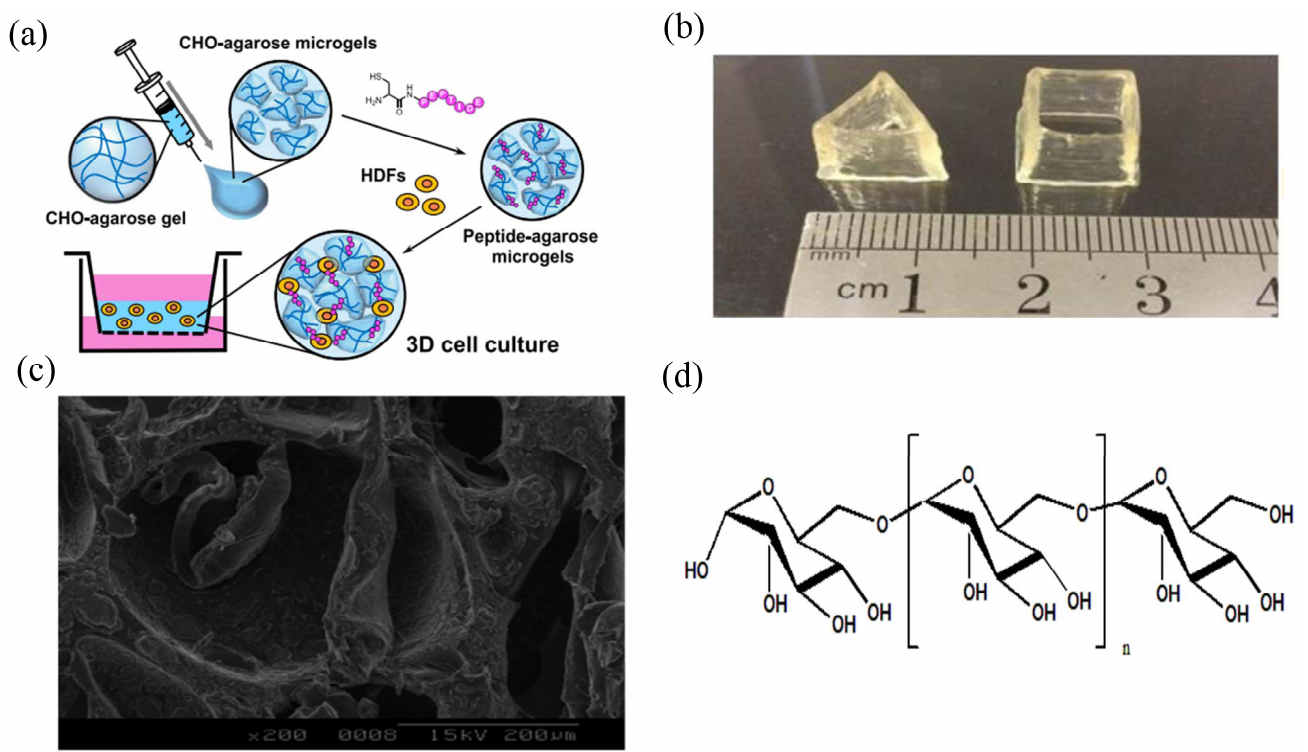
Figure 2. Shape and internal structure of parts of hydrogels. ( a ) Schematic illustration of the preparation of the peptide-agarose microgel scaffold for three-dimensional (3D) cell culture. Reprinted with permission from Ref. [18]. Copyright 2020, Yamada, Y. ( b ) Different forms of carrageenan composite hydrogel. Reprinted with permission from Ref. [23]. Copyright 2017, Liu, S. ( c ) Internal structure diagram of chondroitin sulfate composite hydrogel. Reprinted with permission from Ref.